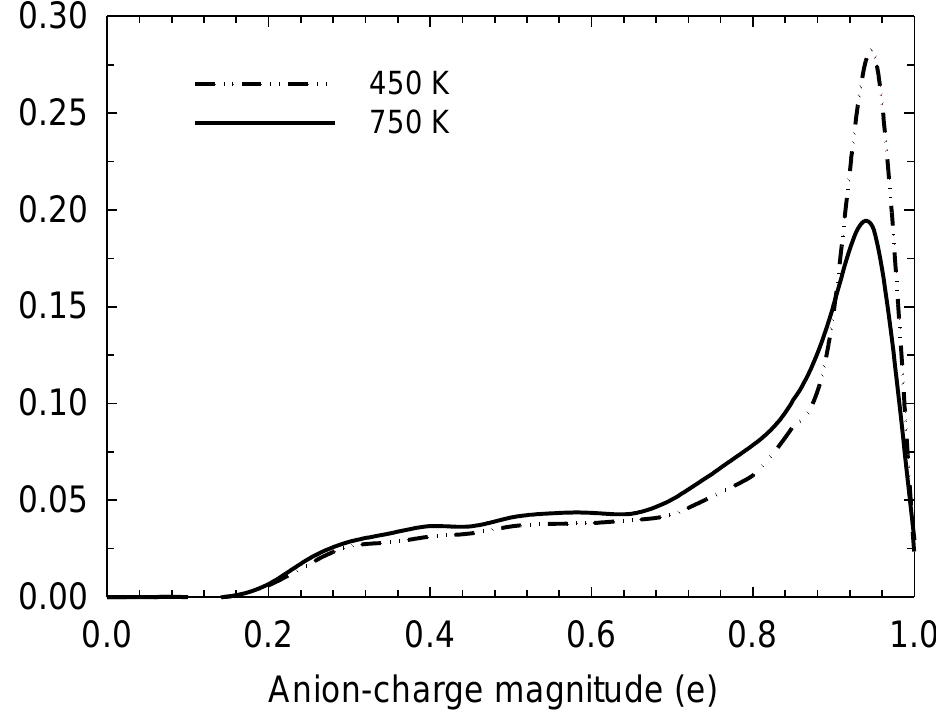
Figure 2. Normalised iodine-atom charge distribution at 450 and 750 K, computed for all iodine atoms in the simulation box.